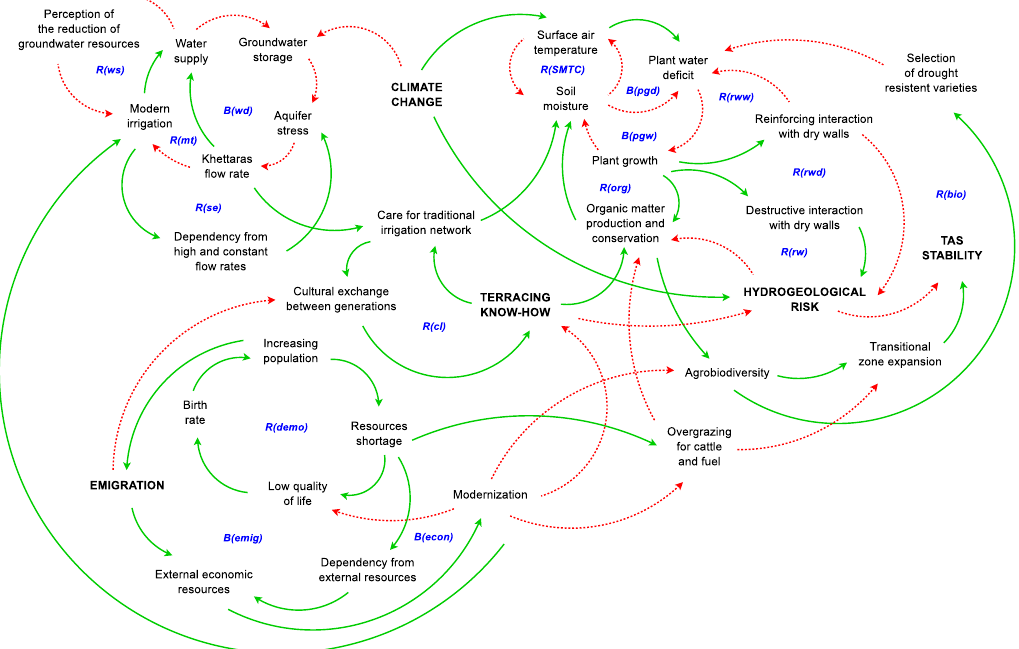
Figure 5. Map of the dynamics in Assaragh, based on system dynamics (SD). Red dotted lines represent negative coupling, e.g., an increase in emigration implies a decrease in cultural exchange between generations. Green lines represent positive coupling, e.g., an increase in cultural exchange between generations increases the know-how retention inside the village in relation to terracing and dry walling. Feedback loops are noted in blue (see glossary in Appendix A for some